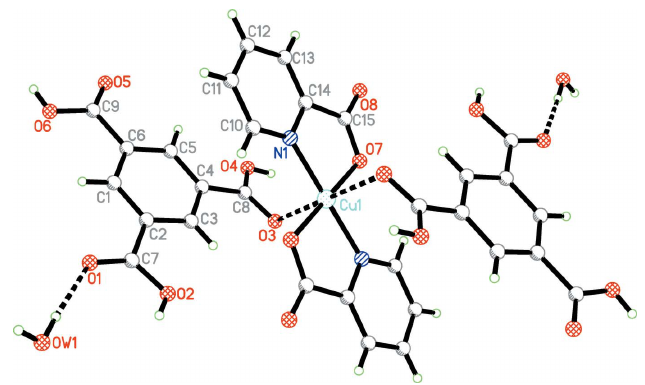
Figure 1 The title compound showing the atom-labelling scheme with displace- ment ellipsoids drawn at the 30% probability level. Unlabelled atoms are generated by the symmetry operation (cid:4) x , (cid:4) y , (cid:4) z . Hydrogen bonds are shown by dashed lines